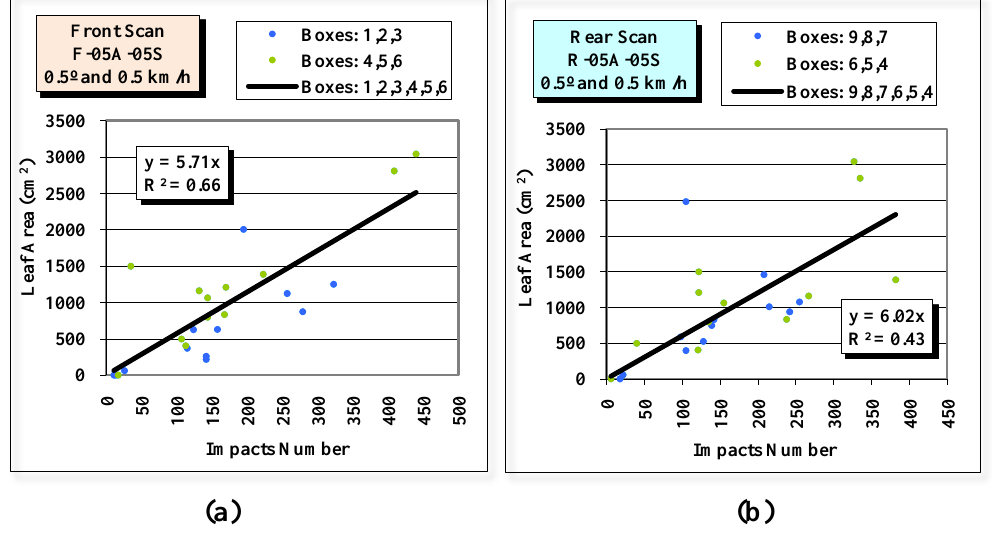
Figure 15. Scatter diagrams, regression lines and R 2 of the relation between the number of impacts received in the 12 divisions (boxes) closest to the LIDAR sensor in the front view scan F-05A-05S (a) and rear view scan R-05A-05S (b) , and the leaf surface area of the same divisions. When obtaining the front view and rear view regression lines, divisions D2 and D8, respectively, were